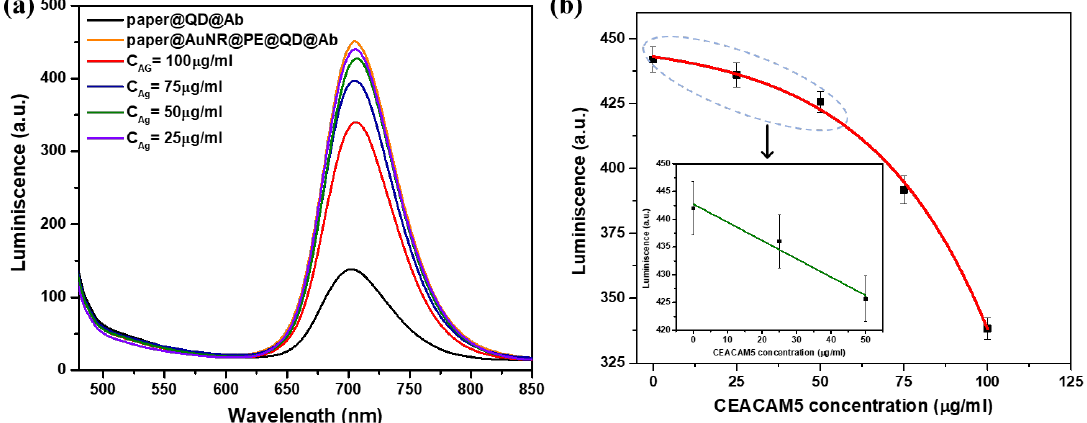
Figure 6. ( a ) Comparison between the luminescence spectrum of QD@Ab (black spectrum) on bare paper and on our plasmonic nanoplatforms (orange spectrum) before and after varied concentrations of CEACAM5 were added. ( b ) The calibration curve (exponential decay, red line) describing the relationship between the luminescence intensity of the QD@Ab complex and the values of the CEACAM5 concentrations; inset, linear plot (green line) of the emission intensity at CEACAM5 concentrations ranging from 0 to 50 µg/mL.